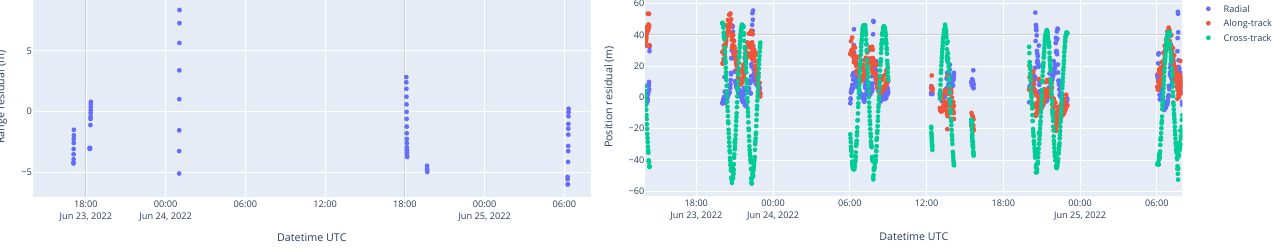
Figure 8. SLR range ( left ) and GPS position residuals ( right ) for a mixed SLR+GPS orbit determina- tion on TUBIN on 25 June 2022 from a 42 h measurement